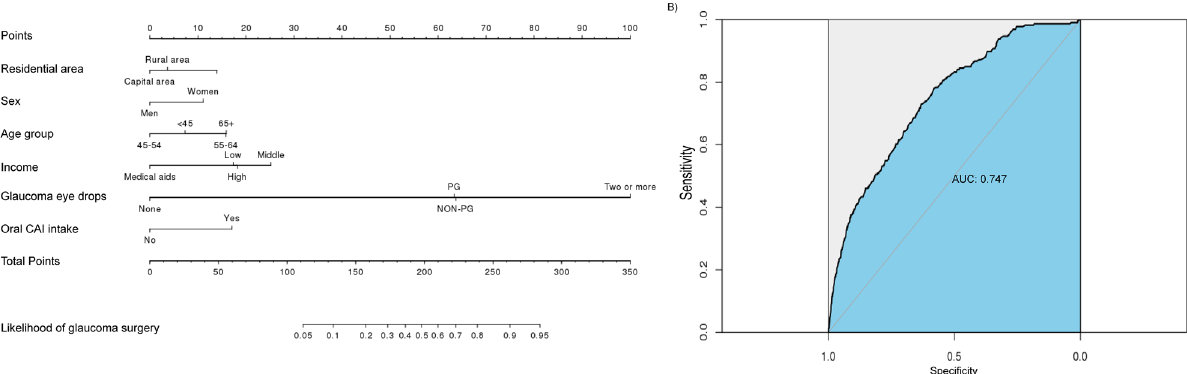
Figure 2. Nomogram and its receiver operating characteristics (ROC) curve for predicting the likelihood for newly diagnosed open-angle glaucoma patients to undergo glaucoma surgery. ( A ) Nomogram from multiple logistic regression model. Find the position of each variable on the corresponding axis and draw a line to the ‘Points’ scale (top axis) to determine the number of points for each variable. Sum the points for all the variables together and draw a line from the ‘Total points’ axis to determine the likelihood of undergoing glaucoma surgery at the bottom. ( B ) ROC curve and its diagnostic performance. AUC: area under the